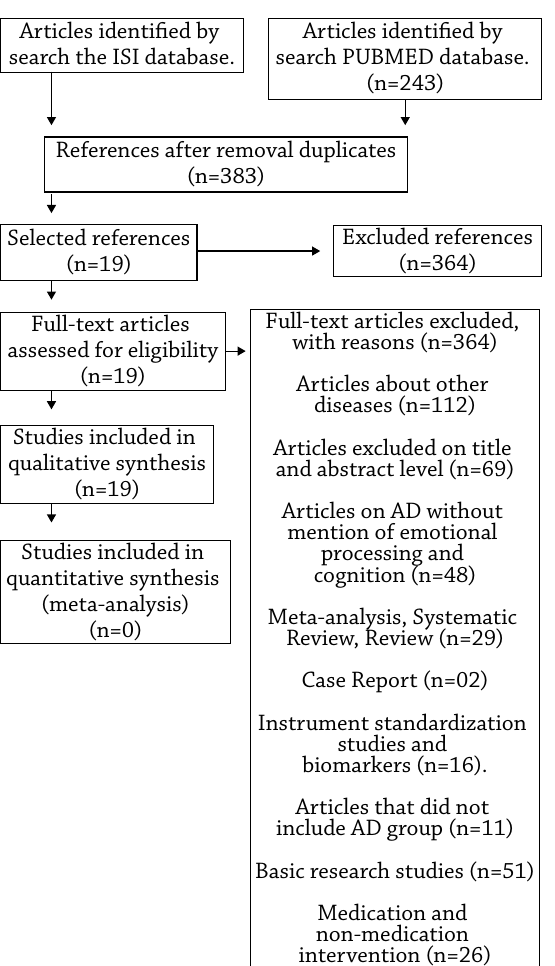
Figure 1. Flow-chart of article